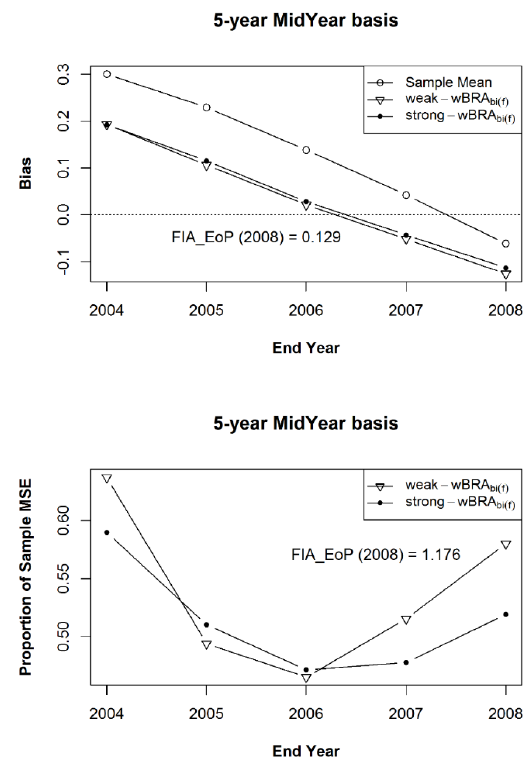
Figure 8. The mean bias ( a ) and the mean of Mean Squared Errors (( b ), expressed as a proportion of the MSE of the sample mean), relative to Estimand 1, for the bias-adjusted EoP Estimator wBRA bi ( f ) (for years 2004–2008), using the weak and strong prior samples, as described in the text, after 100 iterations of samples of size 1000 within the 125 populations of a composite sample of sample observation lengths of five, six, seven, eight, and nine years, in equal